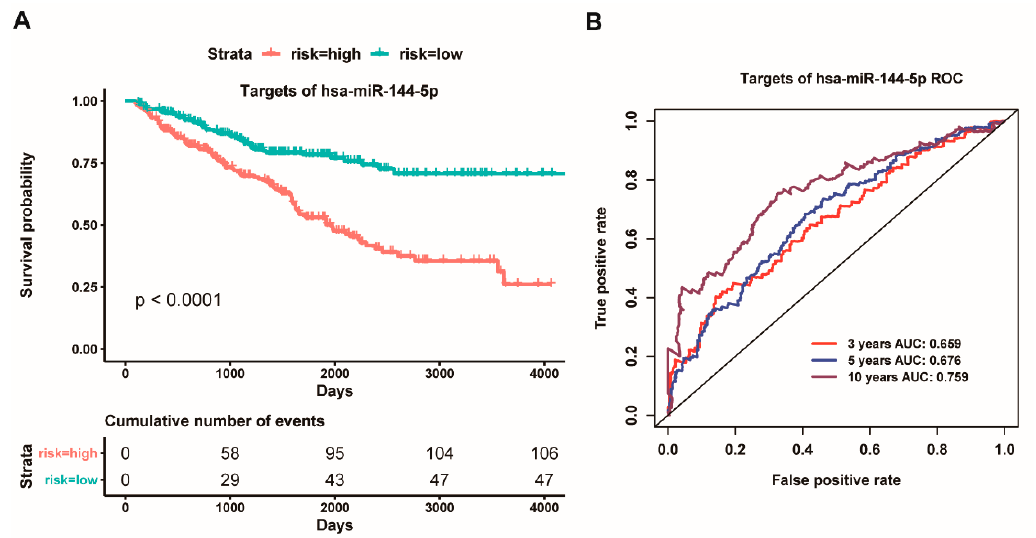
Figure 6. Kaplan Meier survival and ROC curves based on the risk score of five prognostic targets of has-miR-144-5p. ( A ): Overall survival curves for high-risk and low-risk groups based on the prognostic model of a five-gene signature; ( B ): ROC curves for high and low risk from the prognostic model of a five-gene signature.